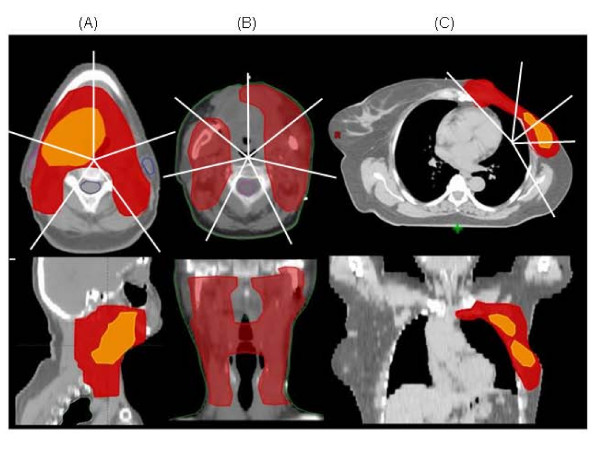
The three planning cases selected for the study. (A) base of tongue, (B) mandible, (C) left thoracic wal. An axial CT slice approximately at the centre of the target volume is shown together with a reconstructed coronal or sagittal view; target volumes are shown as overlays.